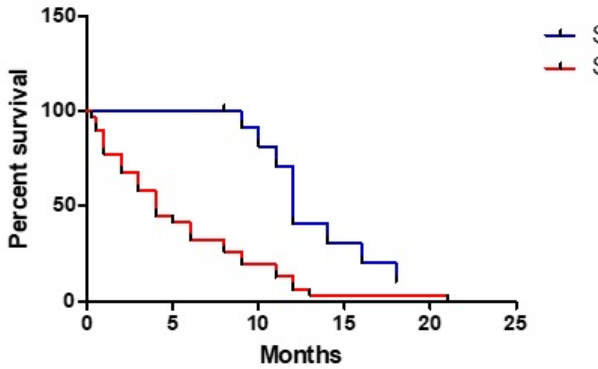
Figure 4. Different effect of a single or a second surgery on overall survival.